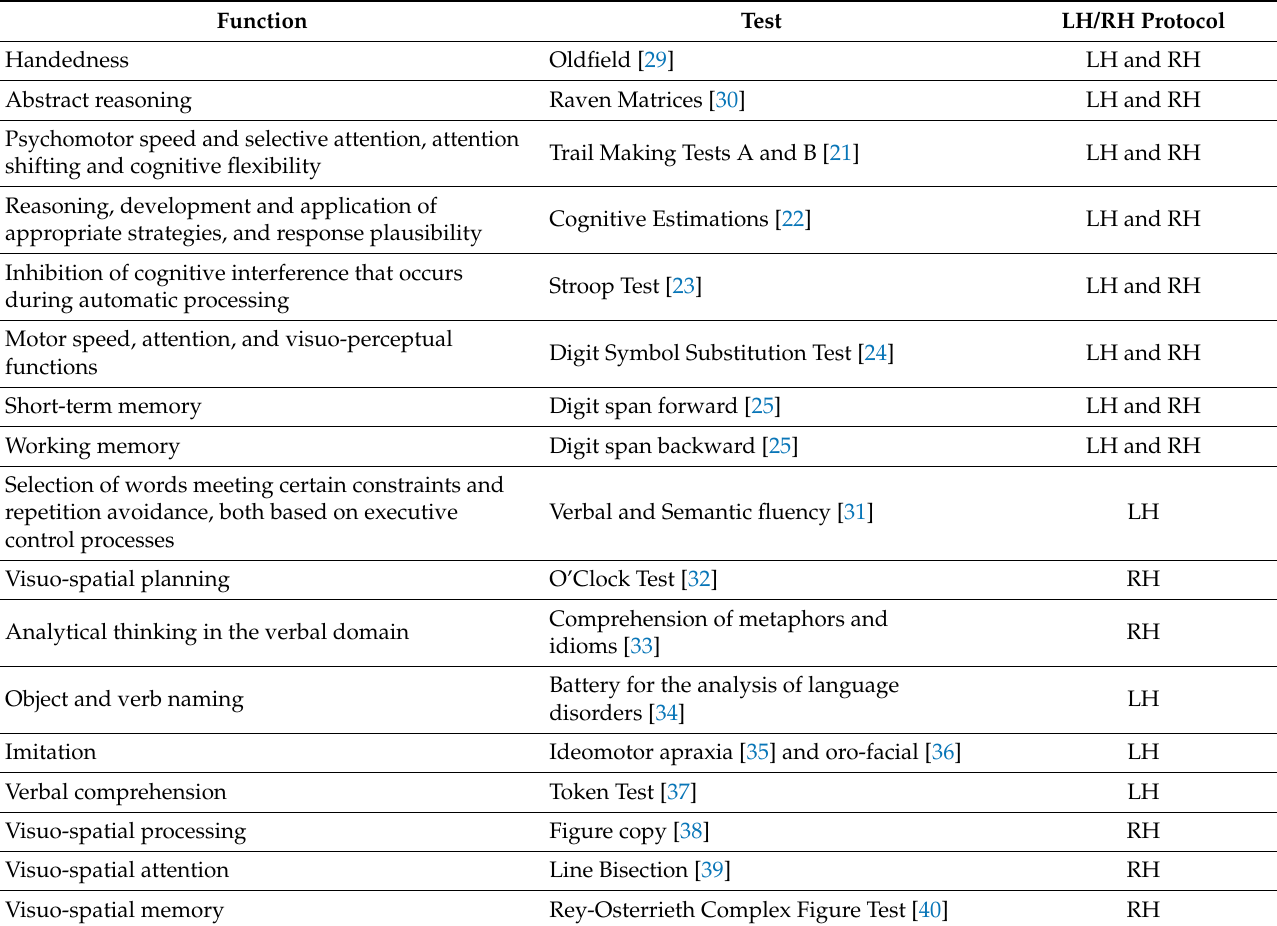
Table 1. Pre- and post-surgery neuropsychological